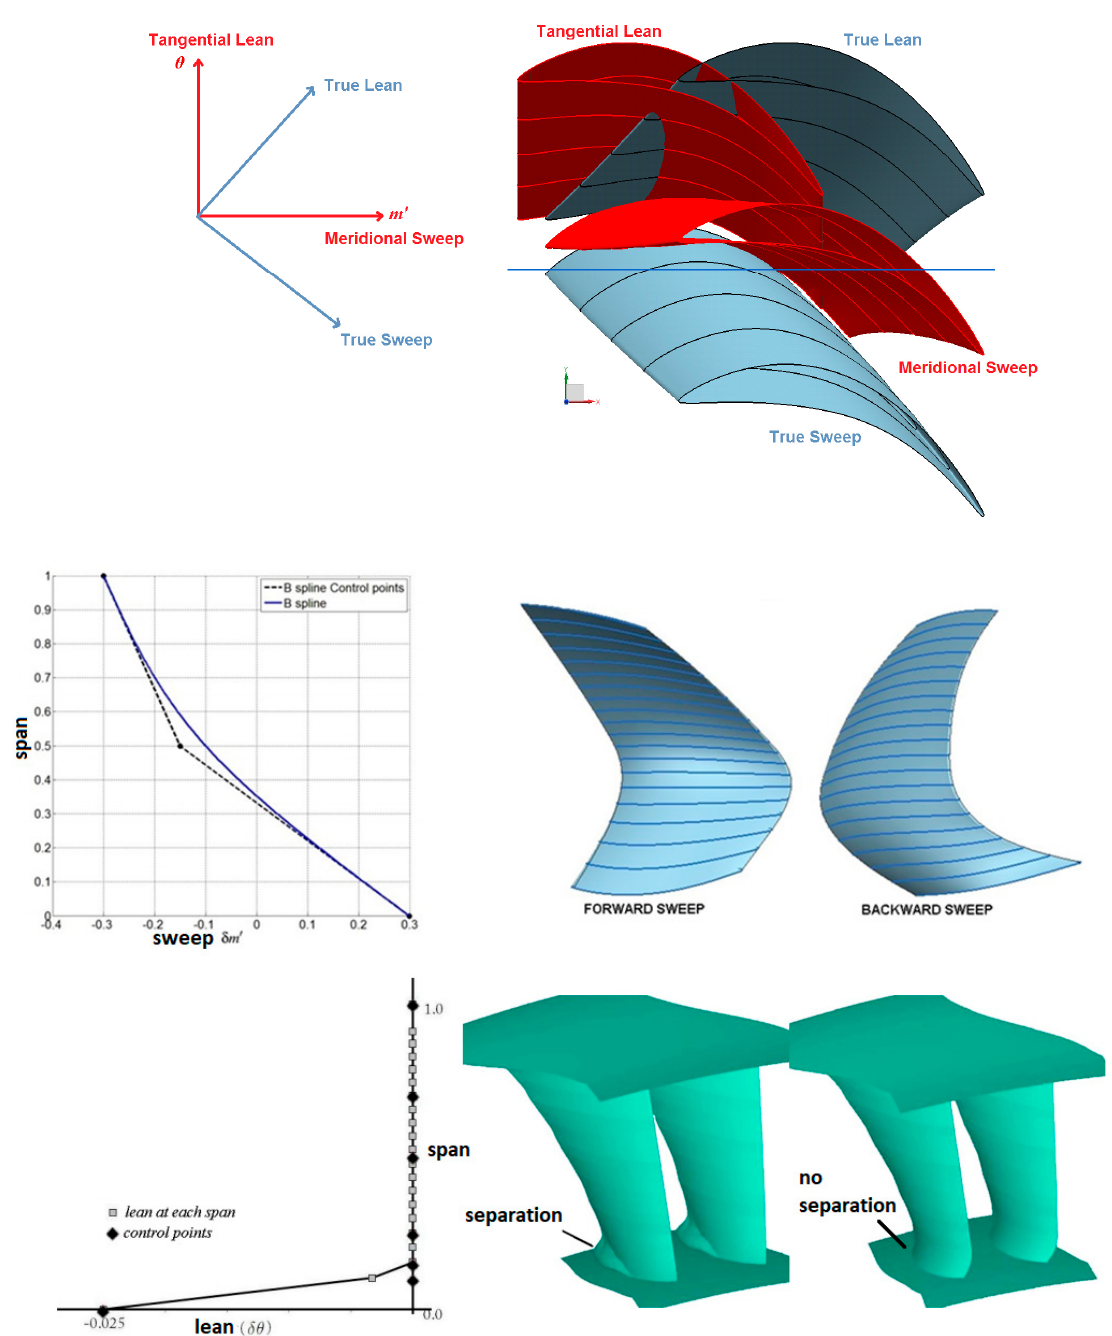
Figure 13. Two types of sweep and lean with spanwise meridional sweep and local lean.